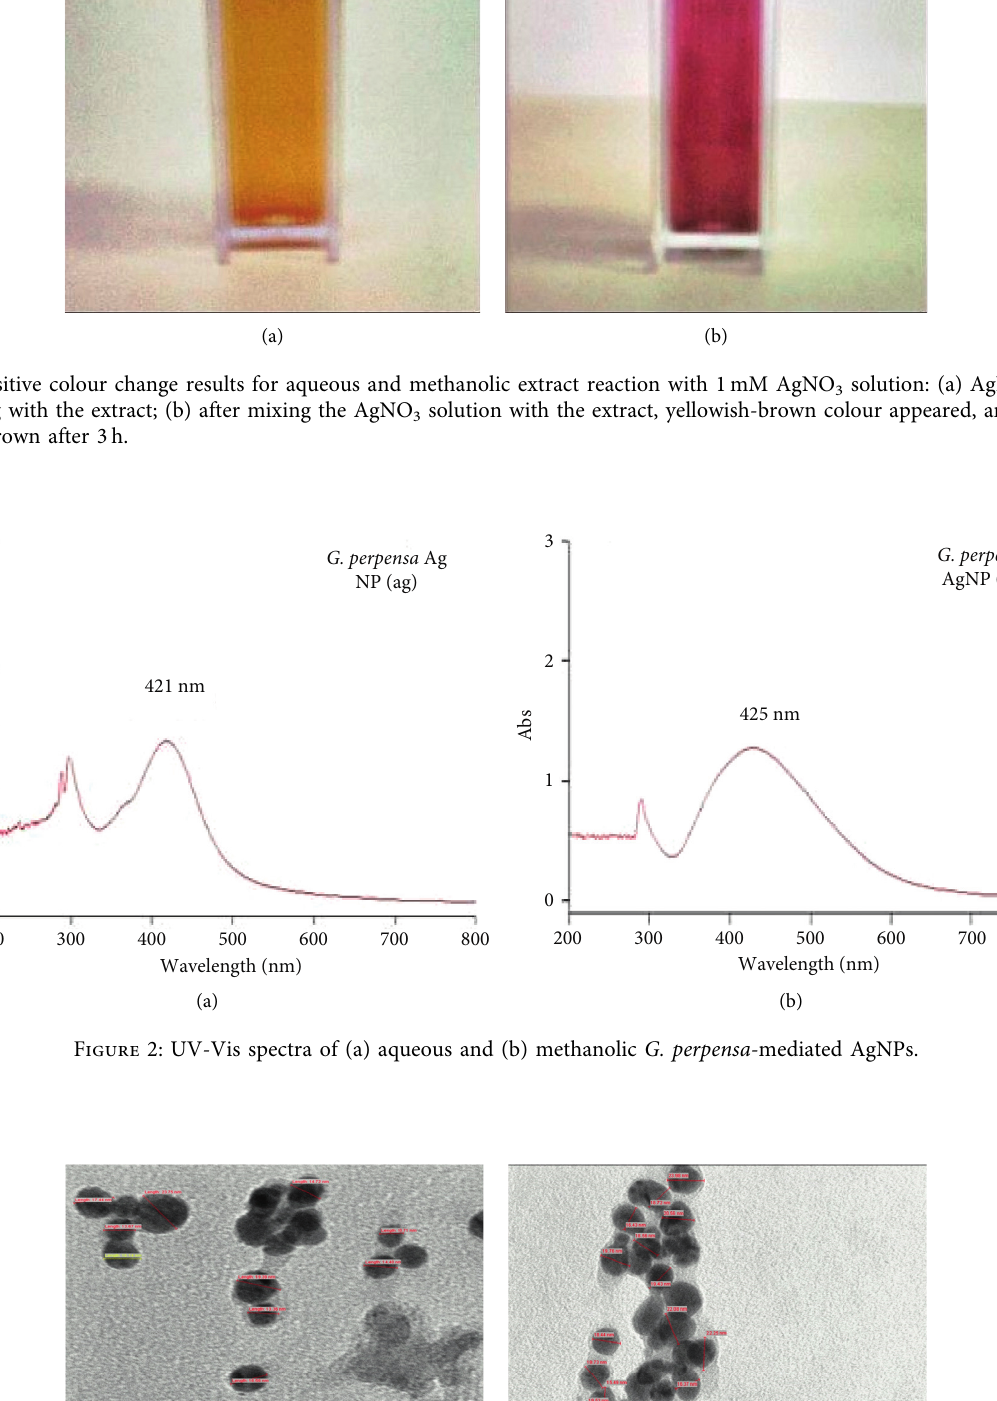
Figure 3: TEM micrographs of (a) aqueous and (b) methanolic G. perpensa -mediated